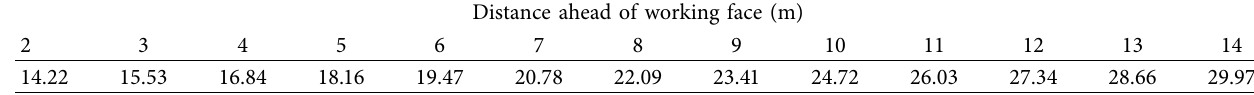
Table 3: The stress values at various points ahead of the working face (MPa).